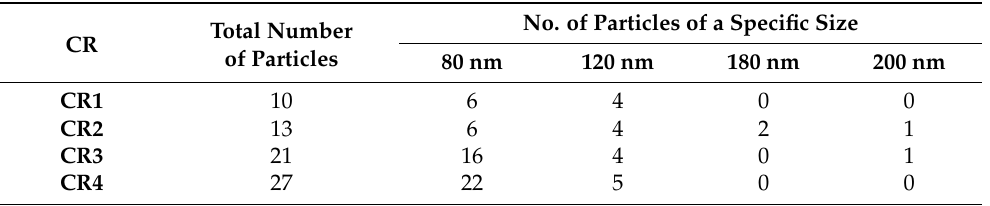
Table 2. Comparison of the outcomes of applying different counting rules to the same set of hypo- thetical particles and in the same images (see Figures 2–5). No. of Particles of a Specific Total Number CR of Particles